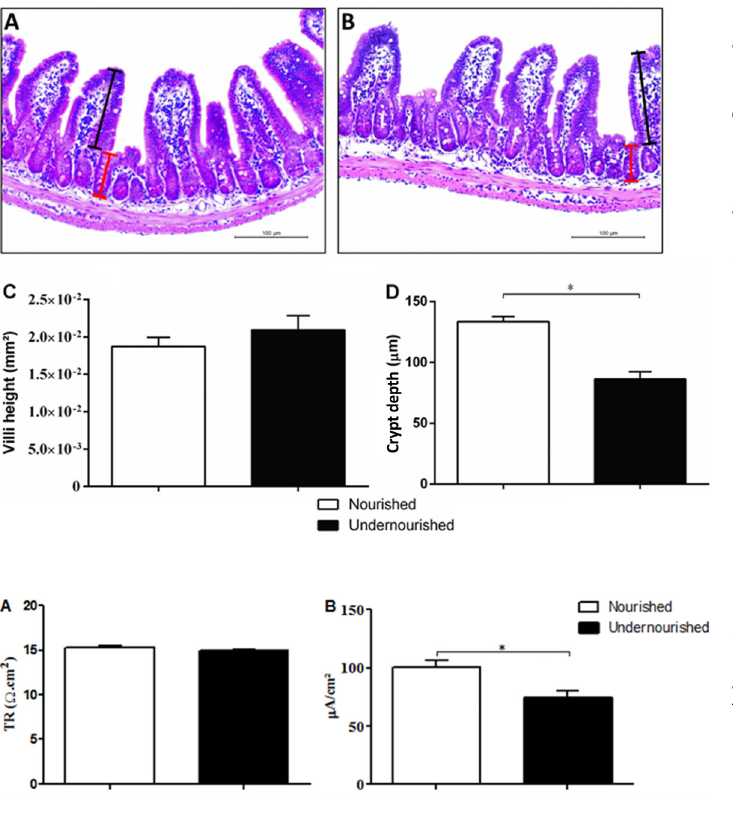
Figure 3. Photomicrographs and morphometric analysis of the ileum of nourished and under- nourished mice. H&E-stained sections from nour- ished ( A ) and undernourished ( B ) mice. Crypt depth and villi height are represented, respectively, by red and black lines in each group ( A , B ). C , the index area of the villi and D , crypt depth from the ileum histological sections are shown for nourished and undernourished groups. Magni fi cation 200 (cid:1) . Data are reported as means ± SE (n=4). *P o 0.01 (Mann-Whitney nonparametric test).